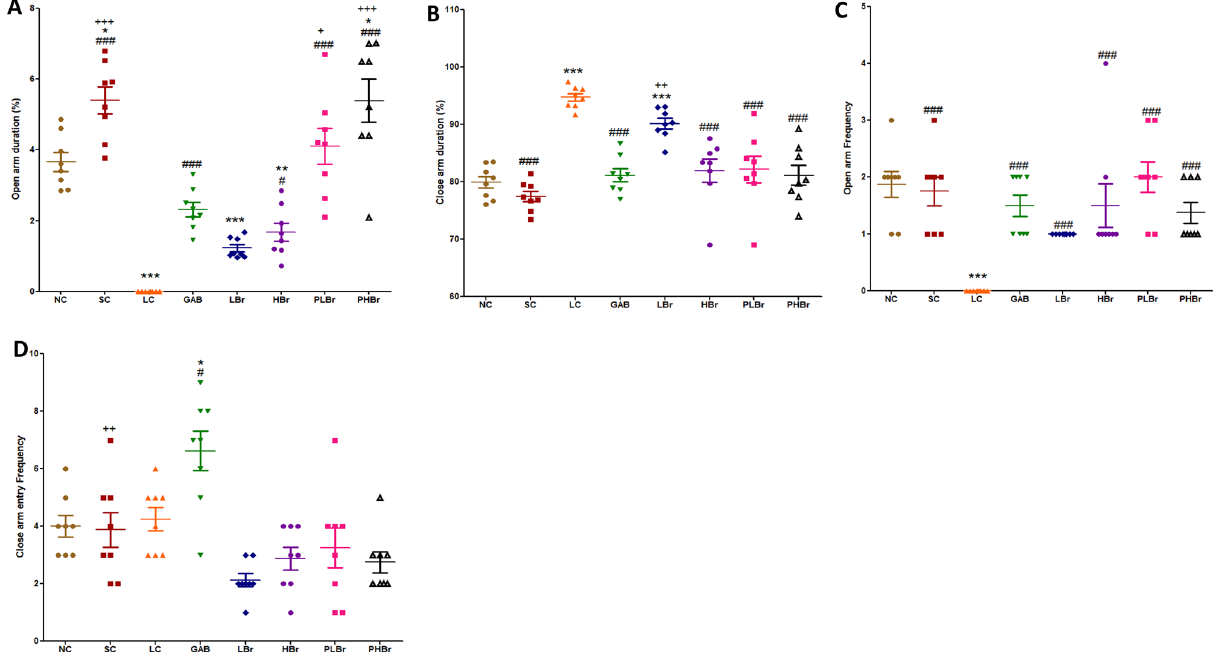
Figure 4. Bromelain reduced anxiety-like behaviour in sciatic nerve induced neuropathic pain in an elevated plus maze. Each values represent mean ± SEM of each group (n = 8). ( A ) Percentage of time spent at the open arm of the elevated maze ( B ) Number of entry into the open arm of the maze ( C ) Percentage of time spent at the close arm of the elevated maze ( D ) Number of entry into the close arm of the maze. # p < 0.05, ## p < 0.01, ### p < 0.001 compared with ligated control; *p < 0.05, **p < 0.01, ***p < 0.001 compared with normal control; + p < 0.05, ++ p < 0.01, +++ p < 0.001 compared with reference control. NC Unligated Normal Control, SC Sham Control, LC Ligated Control, GAB Gabapentin Reference Control (30 mg/kg gabapentin), LBr Low Dose Bromelain (30 mg/kg), HBr High Dose Bromelain (50 mg/kg), PLBr Pre-treated Low Dose Bromelain (30 mg/ kg), PHBr Pretreated High Dose Bromelain (50